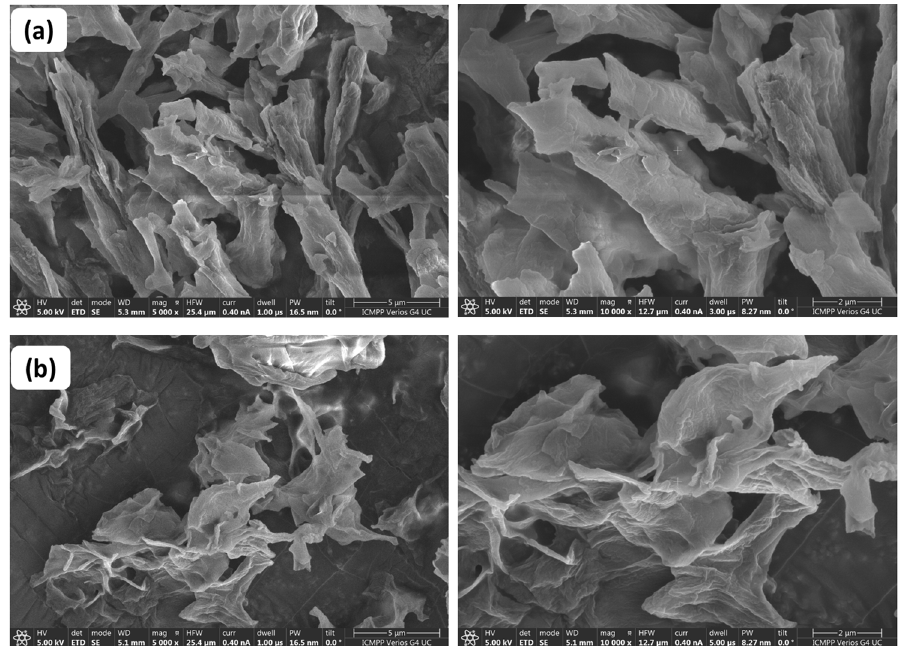
Figure 9. SEM images of the synthesised copolymers: ( a ) PEBSA_solution and ( b ) PEBSA_suspension at different amplifications (5 μ m and 2 μ m).